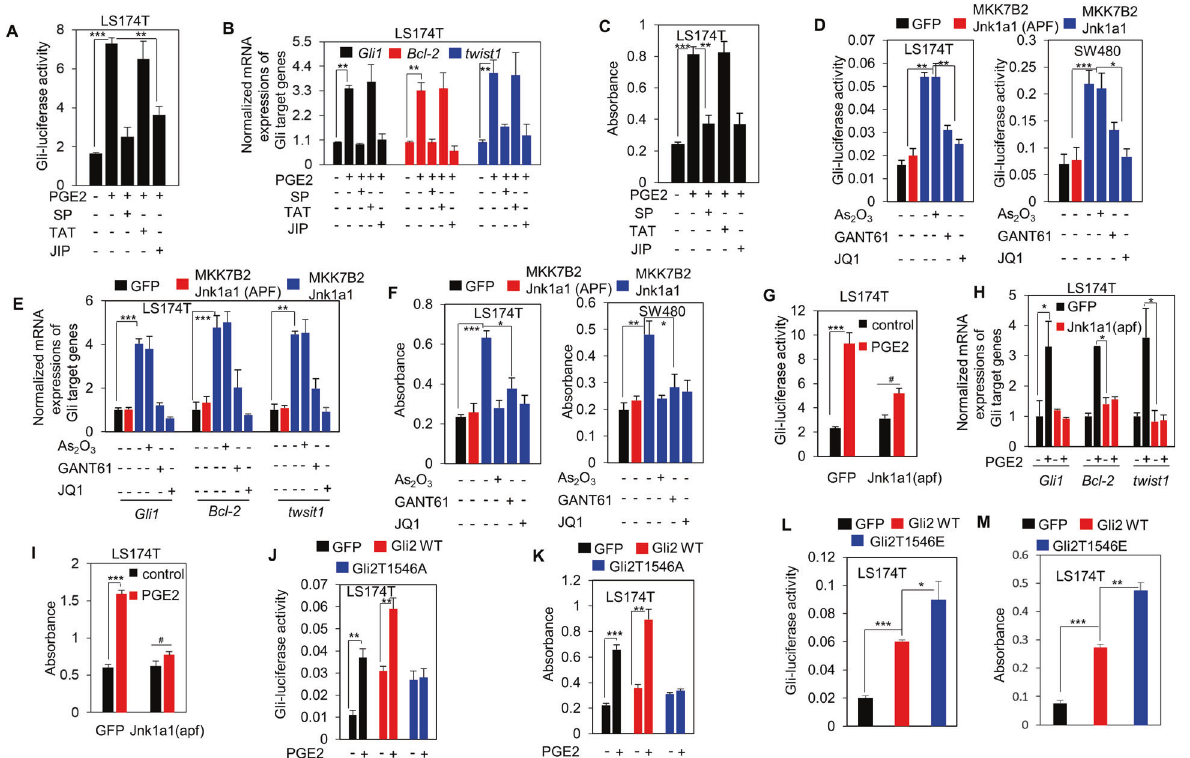
Fig. 4 JNK is required for the Hh activation and proliferation of colorectal cancer cells elicited by PGE2. A Luciferase assay for Gli transcriptional activity in colorectal cancer cells LS174T treated by PGE2, SP, TAT, JIP as indicated for 6 h. Error bars represent SD ( n = 3). B The mRNA levels of Gli target genes in LS174T cells treated by PGE2, SP, TAT, JIP as indicated for 6 h were examined by real-time PCR and normalized to the mRNA level of gusb . Error bars represent SD ( n = 3). C The proliferation of colorectal cancer cells LS174T treated by PGE2, SP, TAT, JIP as indicated for 6 h was examined with BrdU assays. Error bars represent SD ( n = 3). D Luciferase assay for Gli transcriptional activity in colorectal cancer cells LS174T and SW480 cells expressing GFP, MKK7B2Jnk1a1, and MKK7B2Jnk1a1 (APF) after exposure to Gli inhibitors As 2 O 3 (10 μ M), GANT61 (20 μ M), and JQ1 (1 μ M) as indicated for 6 h. Error bars represent SD ( n = 3). E The mRNA levels of Gli target genes in LS174T cells expressing GFP, MKK7B2Jnk1a1, and MKK7B2Jnk1a1 (APF) were examined by real-time PCR and normalized to the mRNA level of gusb after exposure to Gli inhibitors As 2 O 3 (10 μ M), GANT61 (20 μ M), and JQ1 (1 μ M) as indicated for 6 h. Error bars represent SD ( n = 3). F The proliferation of colorectal cancer cells LS174T and SW480 cells expressing GFP, MKK7B2Jnk1a1, and MKK7B2Jnk1a1 (APF) was examined with BrdU assays after exposure to Gli inhibitors As 2 O 3 (10 μ M), GANT61 (20 μ M), and JQ1 (1 μ M) as indicated for 6 h. Error bars represent SD ( n = 3). G Luciferase assay for Gli transcriptional activity in colorectal cancer cells LS174T expressing GFP, and Jnk1a1 (APF) after treated by PGE2 for 6 h. Error bars represent SD ( n = 3). H The mRNA levels of Gli target genes in colorectal cancer cells LS174T expressing GFP, and Jnk1a1 (APF) after treated by PGE2 for 6 h were examined by real-time PCR and normalized to the mRNA level of gusb. Error bars represent SD ( n = 3). I The proliferation of colorectal cancer cells LS174T expressing GFP, and Jnk1a1 (APF) after treated by PGE2 for 6 h was examined with BrdU assays. Error bars represent SD ( n = 3). J Luciferase assay for Gli transcriptional activity in colorectal cancer cells LS174T cells expressing GFP, Gli2 WT, and Gli2T1546A after exposure to PGE2 as indicated for 6 h. Error bars represent SD ( n = 3). K The proliferation of colorectal cancer cells LS174T cells expressing GFP, Gli2 WT, and Gli2T1546A after exposure to PGE2 was examined with BrdU assays. Error bars represent SD ( n = 3). L Luciferase assay for Gli transcriptional activity in colorectal cancer cellsLS174T cells expressing GFP, Gli2 WT, and Gli2T1546E. Error bars represent SD ( n = 3). M The proliferation of colorectal cancer cells LS174T cells expressing GFP, Gli2 WT, and Gli2T1546E was examined with BrdU assays. Error bars represent SD ( n =